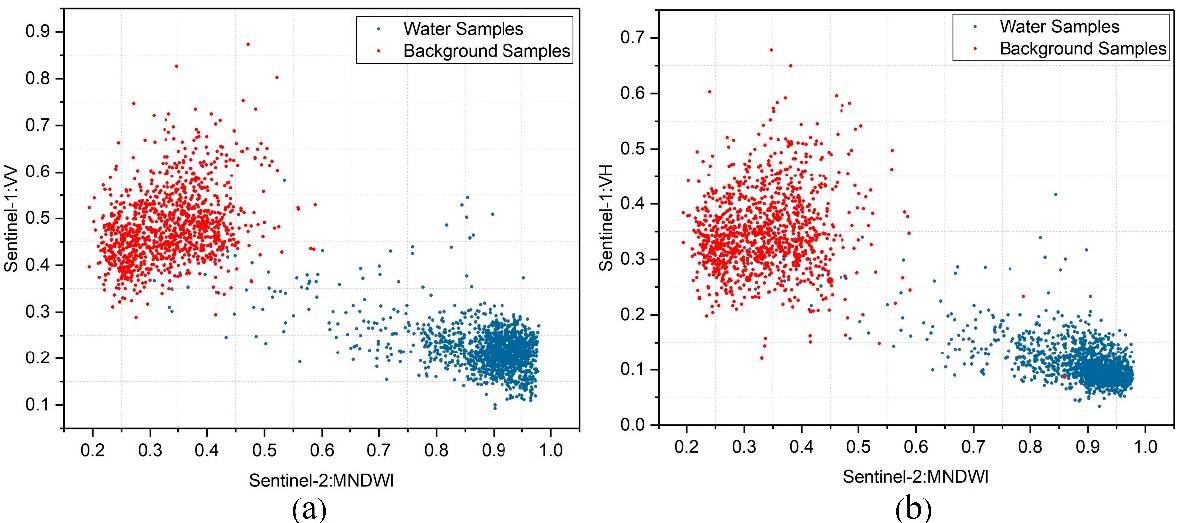
Figure 4. Water and non-water background samples plotted in feature space formed by Sentinel-1: ( a ) VV and ( b ) VH backscatter vs. Sentinel-2 MNDWI.